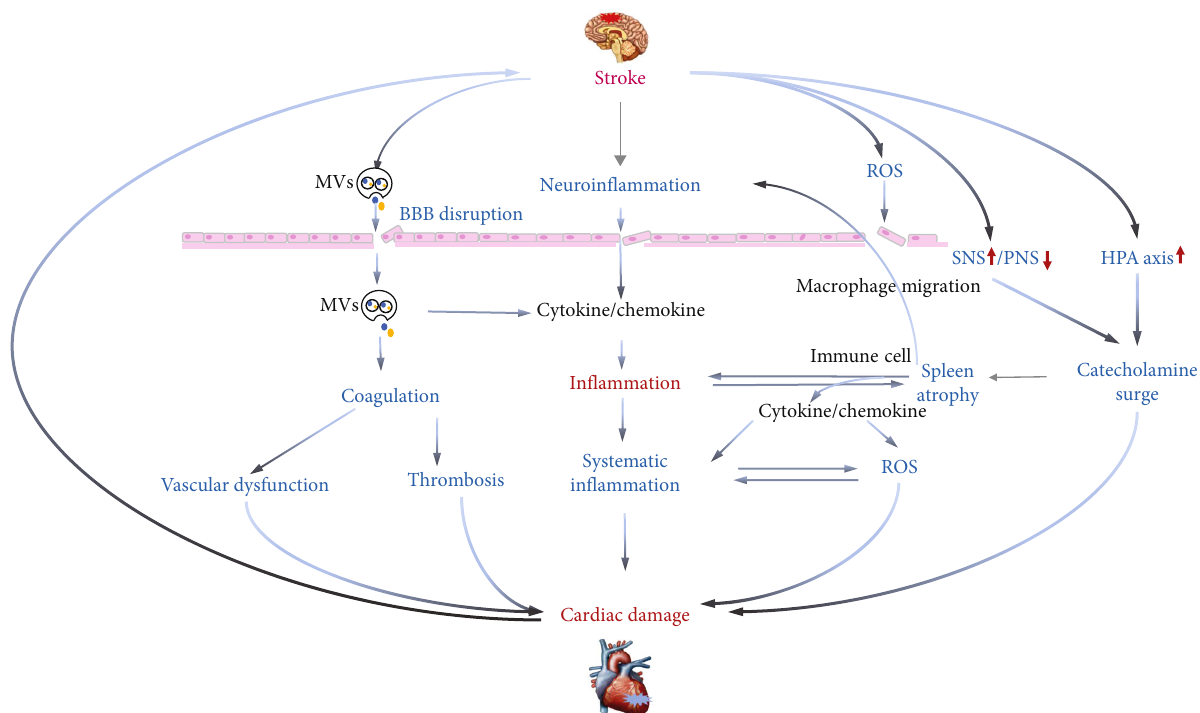
Figure 1: Immune response and in fl ammation in brain-heart interaction. Local in fl ammation induces blood-brain barrier (BBB) disruption, oxidative stress, and autonomic hyperactivity. Local in fl ammation in the injured brain also in fi ltrates into the systemic circulation. Systemic in fl ammatory response syndrome (SIRS) injures myocardial cells directly, as well as the interplay between in fl ammatory response and oxidative stress, cardiac sympathetic/parasympathetic dysfunction, and splenic immunoregulation. Brain-derived microvesicles (MVs) enter into the systemic circulation and then interact with the peripheral immune system. MVs are also involved in thrombus formation. Stroke triggers oxidative stress, and NOX-2 and MCP-1 regulate the release of cytokines/chemokines. Both sympathetic nerve and HPA axis activation cause catecholamine surge. Catecholamines mediate the increase of in fl ammatory cytokines, as well as spleen atrophy. The spleen regulates the immune response by increasing circulating lymphocytes, cytokines, chemokines, and macrophage migration. SIRS: systemic in fl ammatory response syndrome; BBB: blood-brain barrier; MVs: microvesicles; SNS: sympathetic nervous system; PNS: parasympathetic nervous system; ROS: reactive oxygen species; NOX-2: nitric oxide-2; MCP-1: monocyte chemoattractant protein-1; HPA: hypothalamic-pituitary